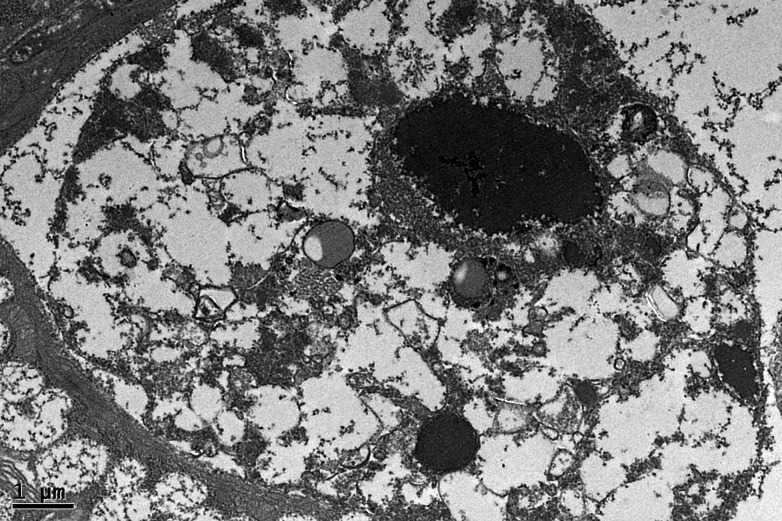
The apoptosis cell of OVX group in submandibular gland.The apoptosis cells were commonly seen in OVX group, with a rupture of membrane structures, including the cell membrane, mitochondria membrane and nuclear membrane, etc. The scale bar represents 1μm.